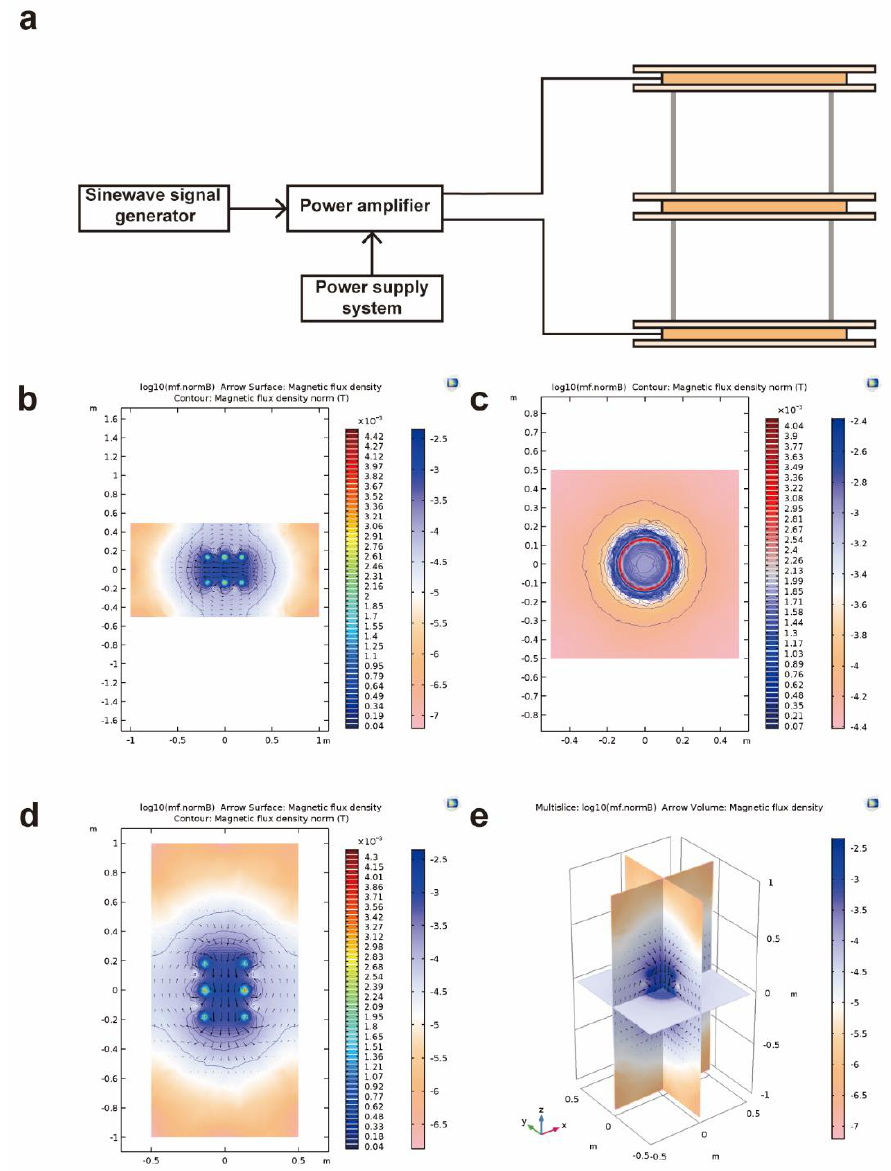
Figure 8. Schematic diagram of the MF exposure system and simulation of MFs produced by the Helmholtz coils. ( a ) The MF exposure system consists of a waveform generator, power amplifier, power supply, and improved Helmholtz coils. ( b ) X-Z plane of 2D magnetic field simulation of three coils at y = 0. The color bar represents the relative value of the magnetic field using a log base of 10. The arrow shows the direction of the magnetic field and the contour represents isoline. ( c ) X-Y plane of 2D magnetic field simulation of three coils at z = 0. ( d ) Y-Z plane of 2D magnetic field simulation of three coils at x = 0. ( e ) Three-dimensional simulation of the Helmholtz coils.